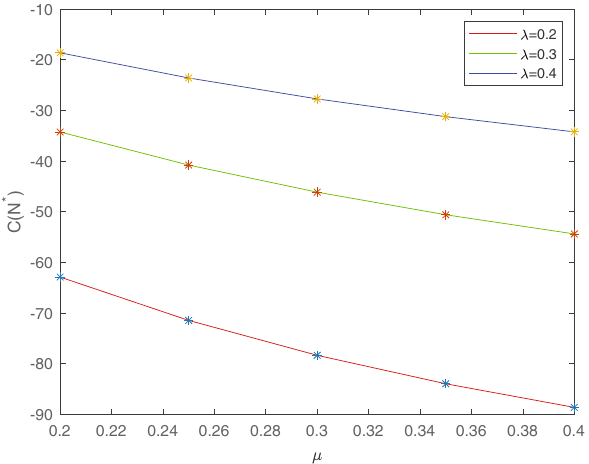
Figure 4: The e ff ect of parameter ( ) ∗ λ μ N , and ( ) ∗ C N .